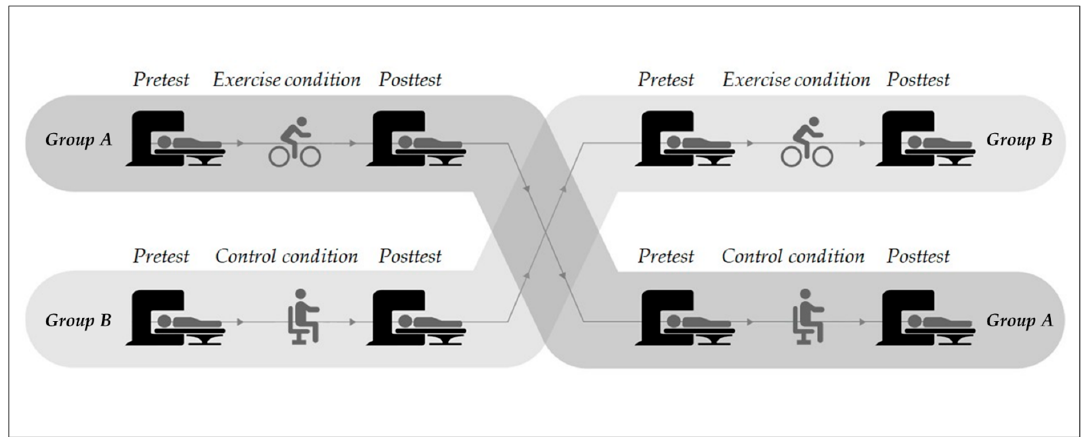
Figure 4. Schematic illustration of the recommended study design (a within-subject crossover design with a pretest-posttest comparison).